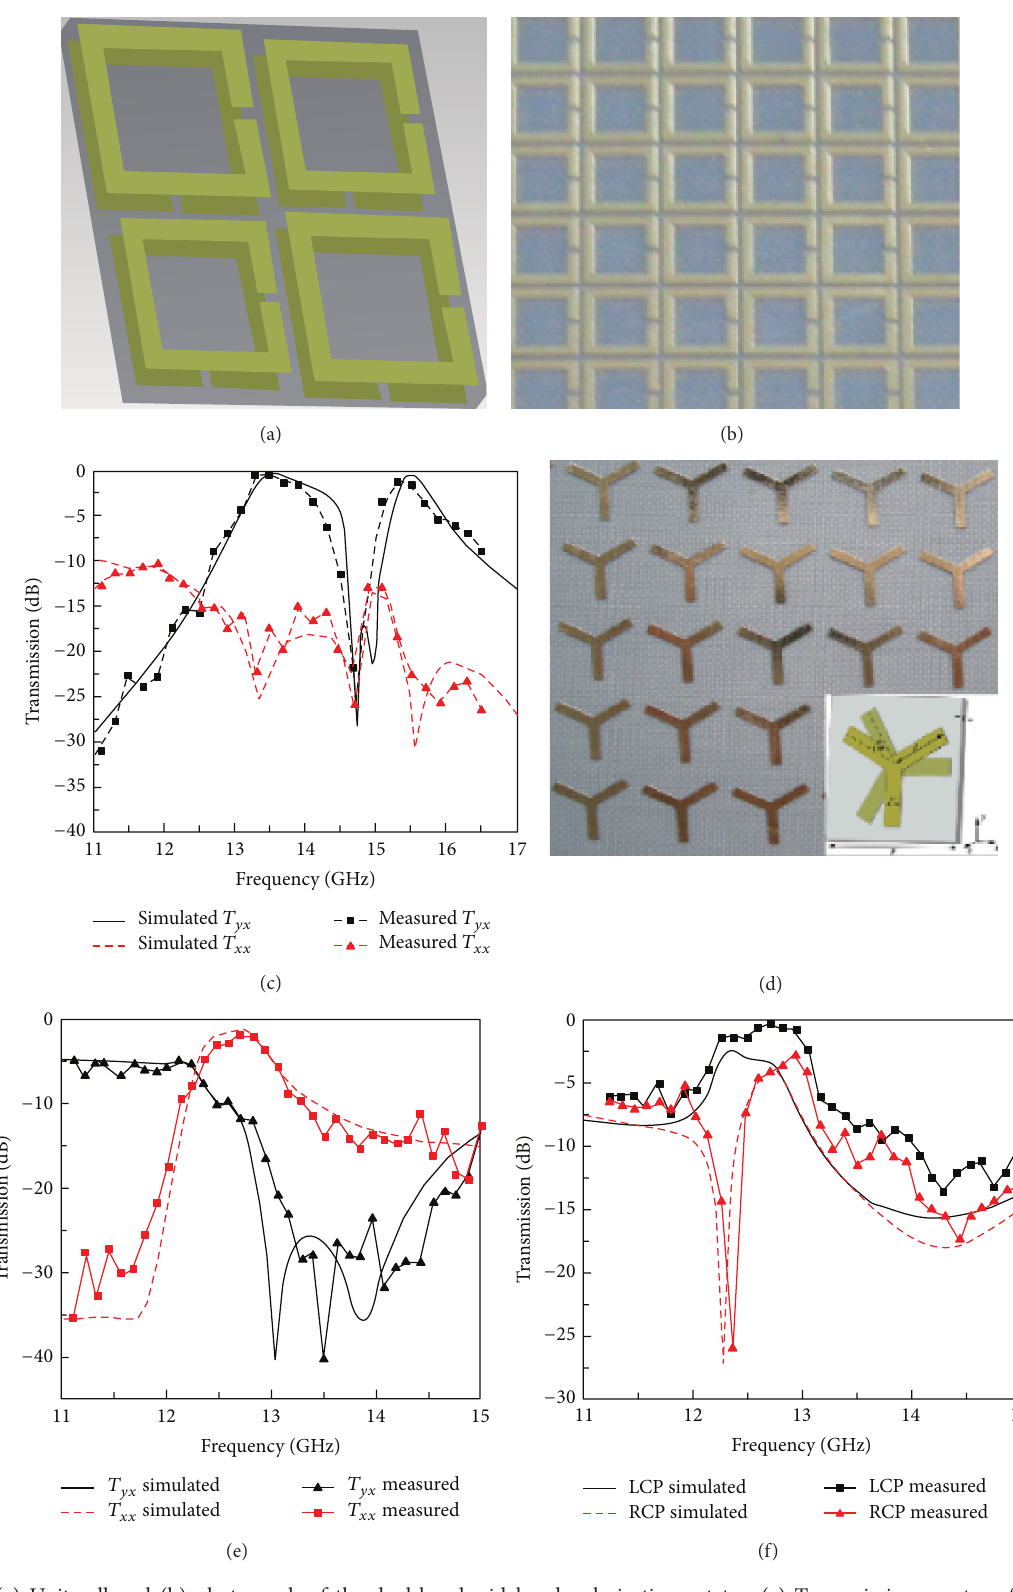
Figure 13: (a) Unit cell and (b) photograph of the dual-band wideband polarization rotator. (c) Transmission spectra of (b). (d) The photograph of the twisted Y-shape chiral metasurface and transmission spectra for (e) linear polarization and (f) circular polarization. Figures are reproduced from [91,